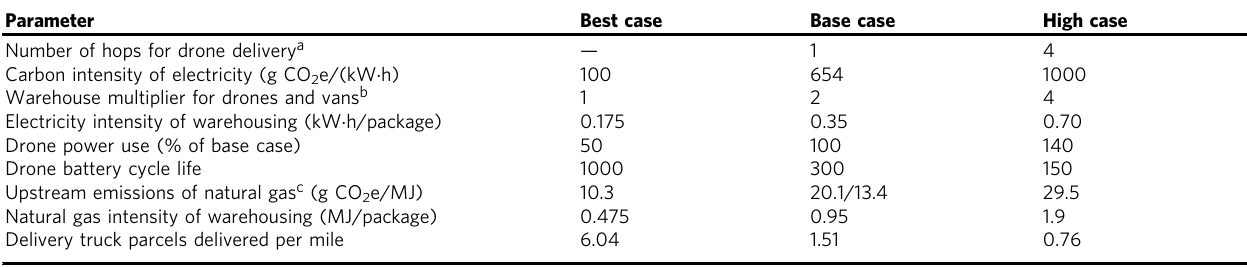
Table 2 Parameter values used in the sensitivity